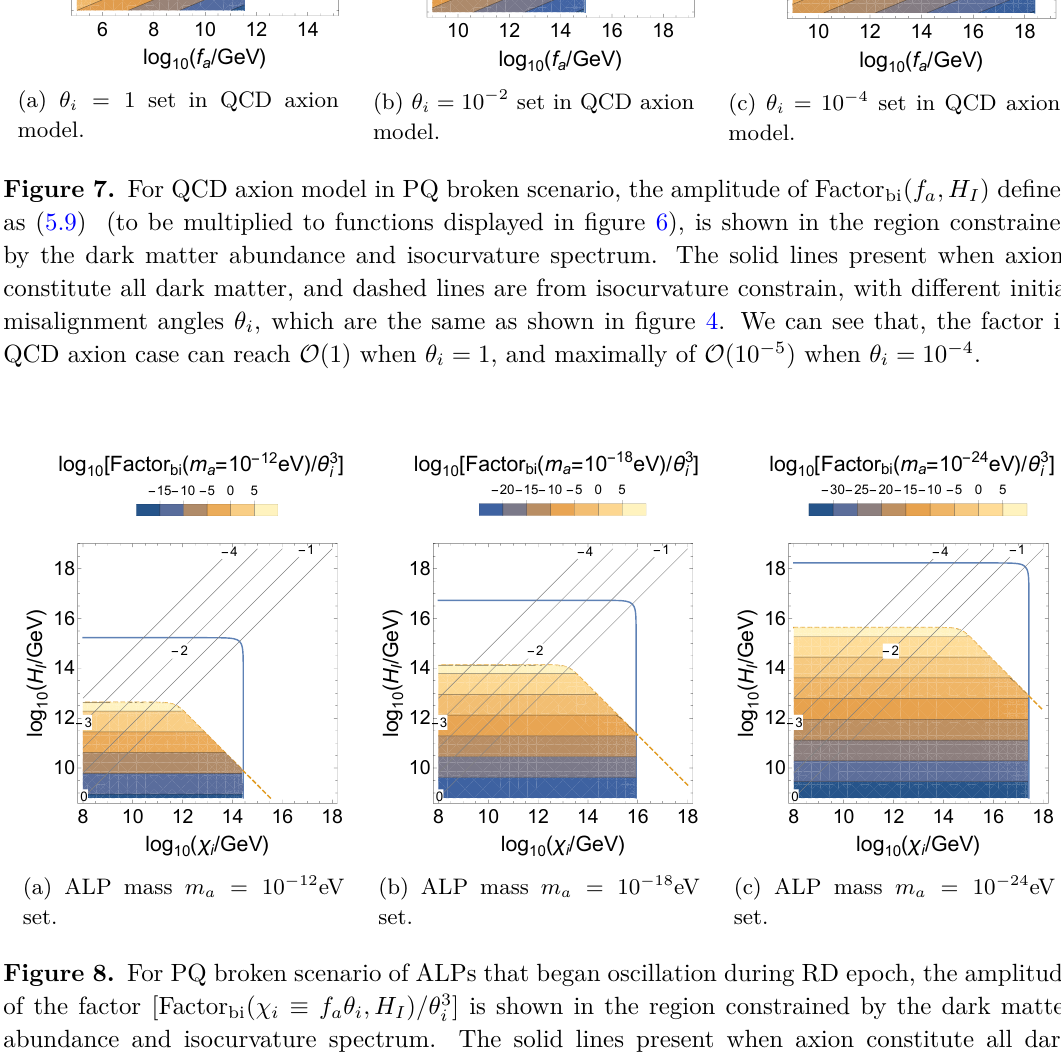
Figure 8. For PQ broken scenario of ALPs that began oscillation during RD epoch, the amplitude of the factor [ Factor ( χ ) /θ 3 ] is shown in the region constrained by the dark matter bi i ≡ f a θ i , H I i abundance and isocurvature spectrum. The solid lines present when axion constitute all dark matter, and dashed lines are from isocurvature constrain, which are the same as shown in figure 5. The gray lines show the upper bounds H = 2 πχ for PQ broken condition, with different I i /θ i log θ i . We can see that, the factor in ALP model is allowed to reach a large value with reasonable 10 parameters, for cases with different m a